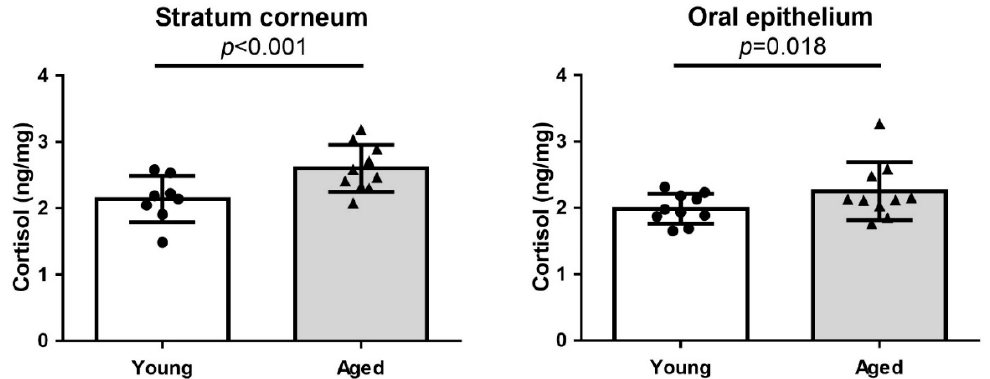
Figure 1. Cortisol levels in the stratum corneum (SC) ( left ) and oral epithelium ( right ) collected from young and aged participants (n = 10 each). The cortisol levels both in the SC of the forearms and in the oral epithelium of the buccal mucosa were significantly higher in the aged group than in the young group. The data are presented as the means ± SD.